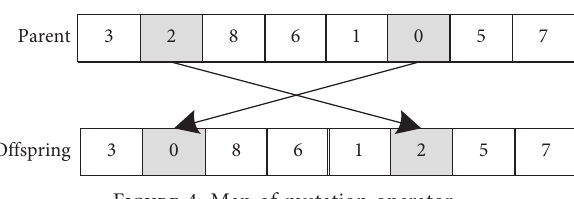
Figure 4: Map of mutation operator. Table 1: Parameter setting for nonrefrigerated vehicles. Parameter